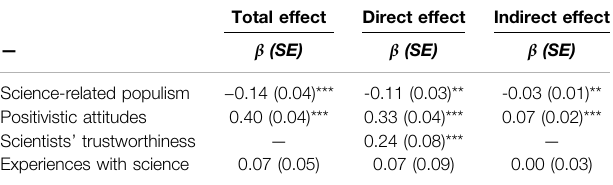
TABLE 1 | Standardized path coef fi cients of the predictors on trust in